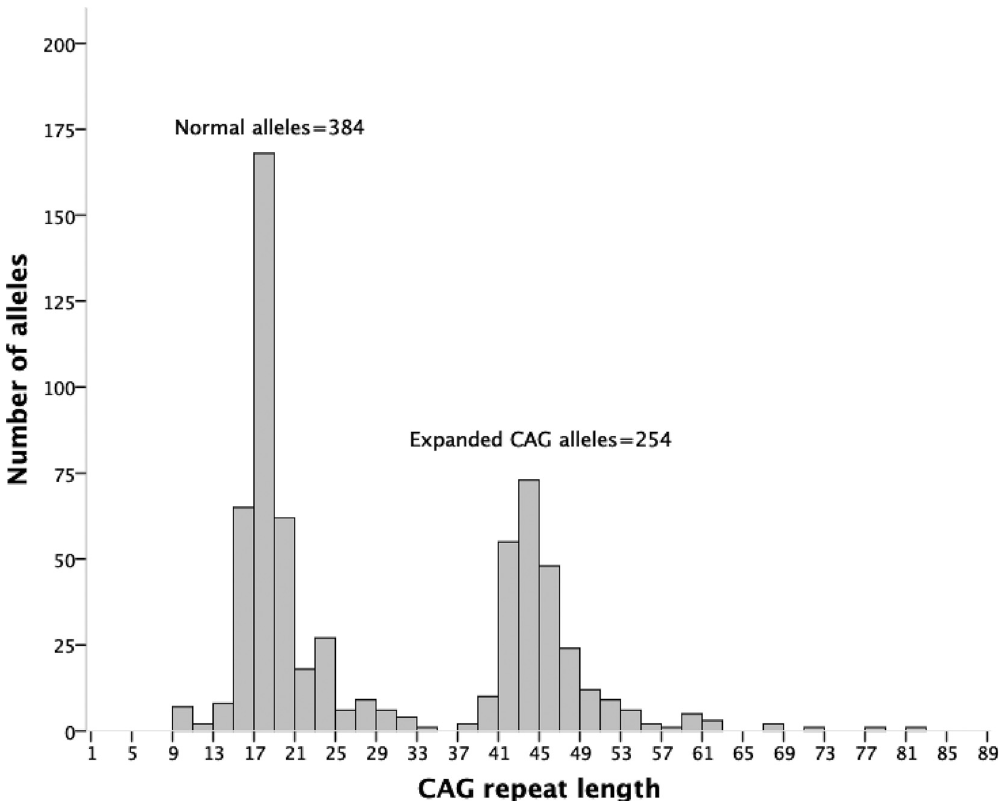
Table 2 - Intergenerational transmissions of expanded HTT CAG repeat, according to gender of affected parent.